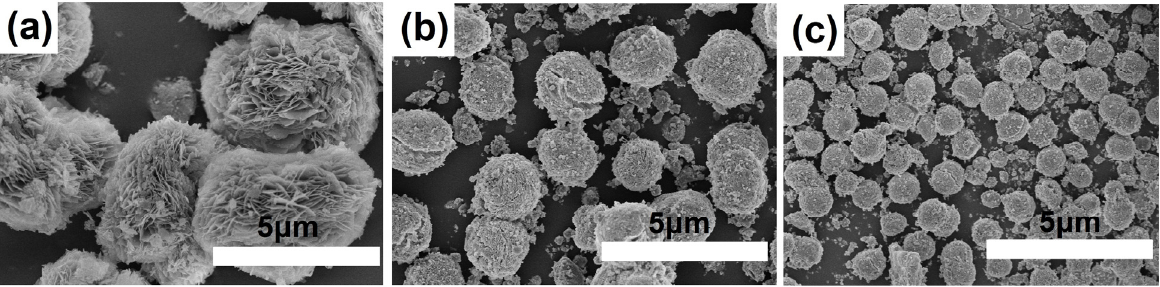
Figure 9. SEM images of gels aged at 120 °C: ( a ) Sample SAPO-TR(120); ( b ) Sample SAPO-SB(120); ( c ) Sample SAPO-RP(120). ( c ) Sample